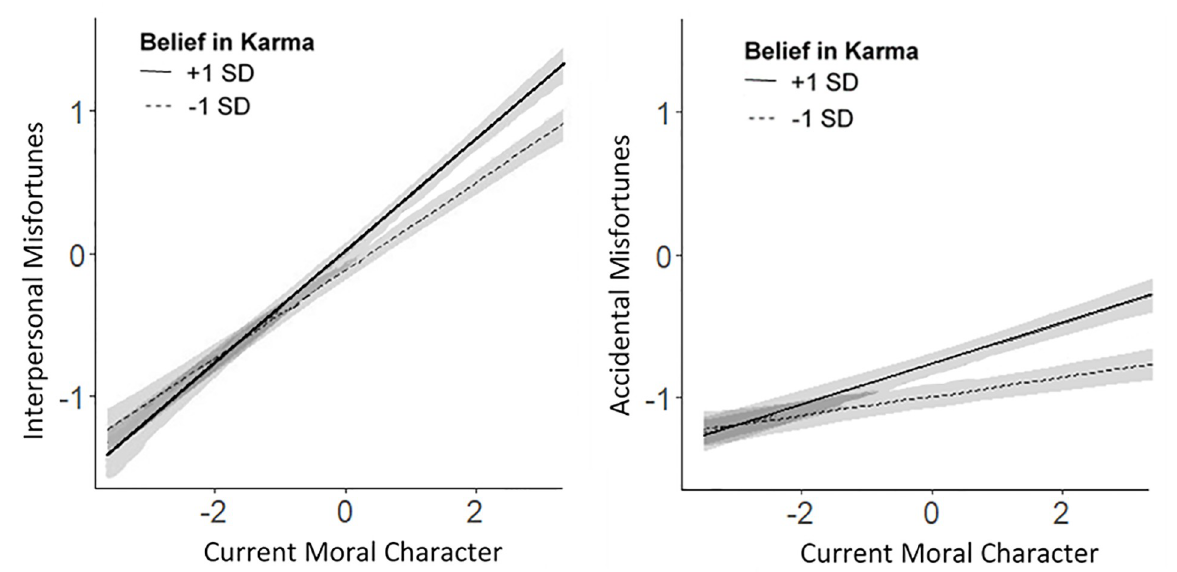
Fig 3. Regression, with 95% confidence bands, showing that participants’ belief in karma moderated the relations between inferences about current moral character and forecasts about future misfortunes. Regression lines are plotted from data aggregated across all studies. forecasts about interpersonal misfortunes ( b = 0.044 [0.019, 0.069], p = < .001), but it did not moderate the relation with forecasts about accidental misfortunes ( b = -0.003 [-0.020, 0.014], p = .72).